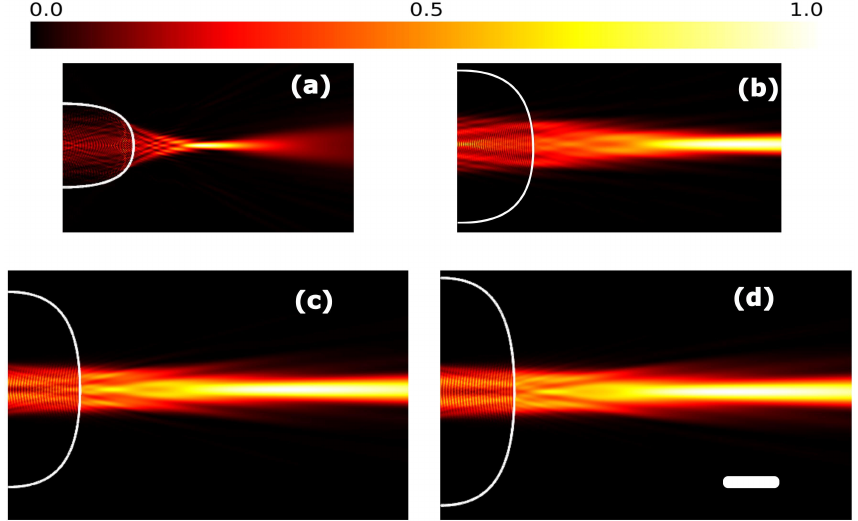
Figure 2. Photonic jet generation (intensity | E | 2 ) for a 20/125 silica optical fiber, n g = 1.440 and n c = 1.457 (NA of 0.22). Excitation by the fundamental mode at a λ = 1064 nm. Tips with h = 26 µm, W 0 = 1.1, ( a ) D = 30 µm, ( b ) D = 50 µm, ( c ) D = 70 µm, ( d ) D = 80 µm. White scale bars represent 20